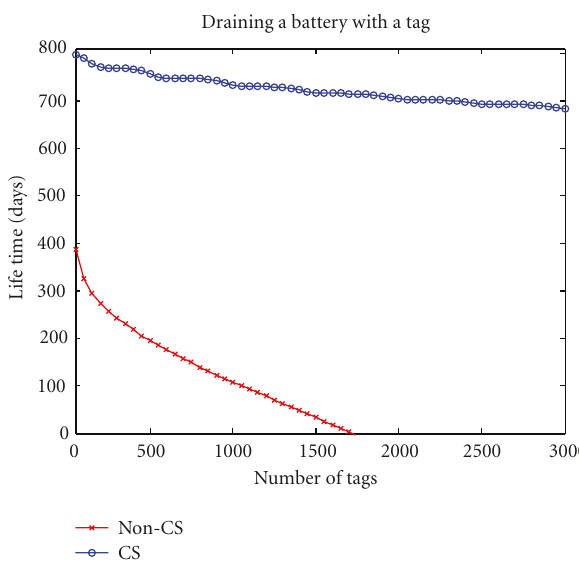
Figure 5: Lifetime of a tag powered CR2032 (150mAh) lithium cell. The non-CS curve is extrapolated above